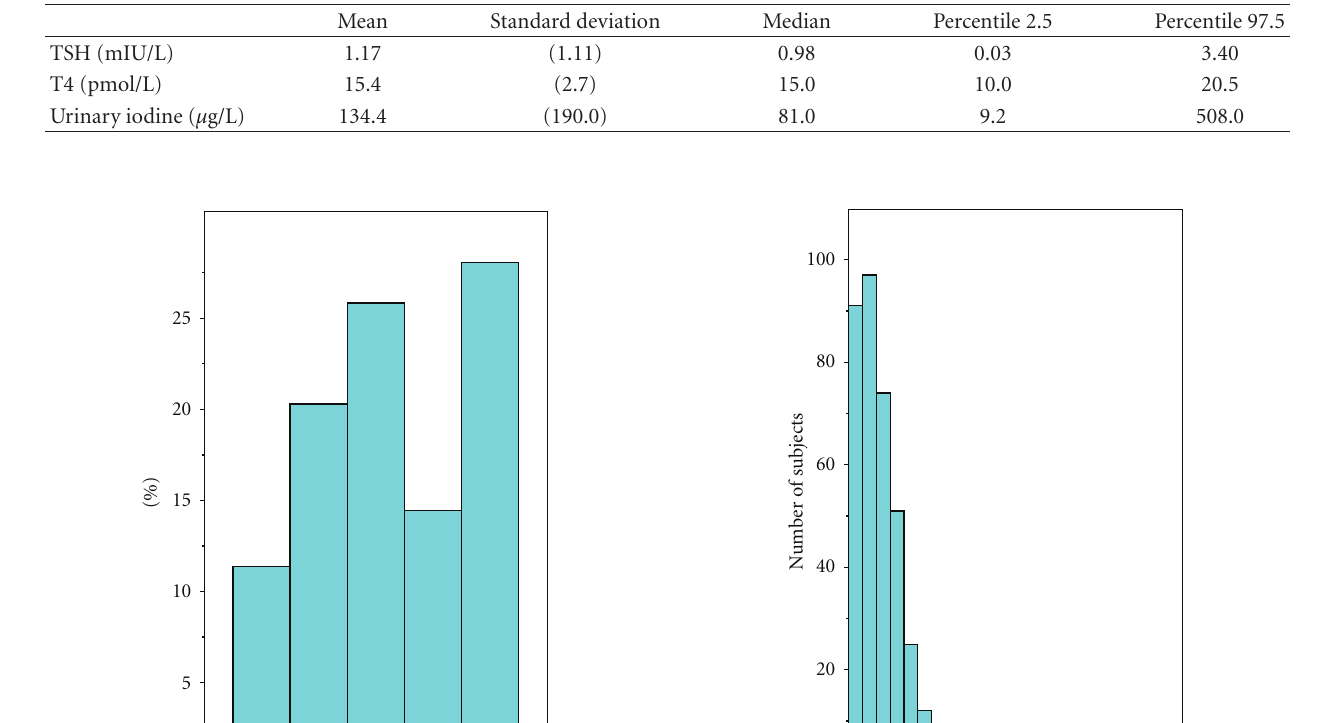
Table 3: Mean, SD, median, 2.5th, and 97.5th percentiles for TSH, Free T4, and UI concentrations.